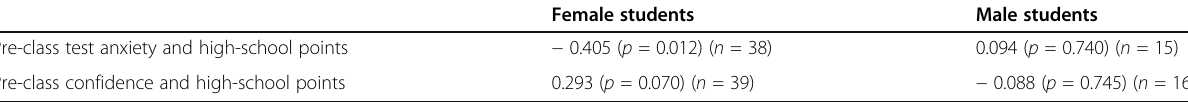
Table 4 Correlations among high-school points, test anxiety, and confidence Pre-class test anxiety and high-school points Pre-class confidence and high-school